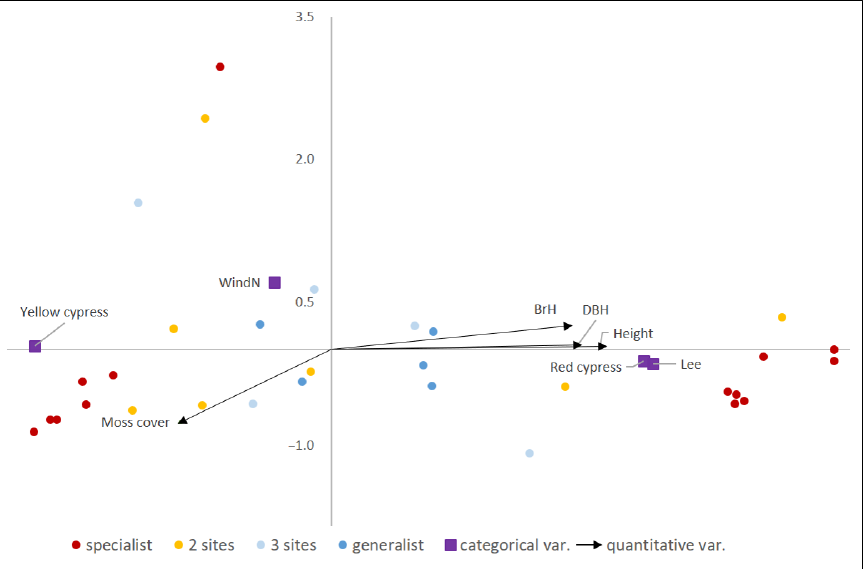
Figure 8. Triplot graph of canonical correspondence analysis (CCA) showing the scores of epiphytic species (circles), category variables (squares: site, host ‐ tree species), and quantitative variables (line arrows: moss ‐ cover, host ‐ tree height, DBH, and branch height (BrH)) from the study in the first two axes. Explanatory variables shown were found significant by 999 permutation tests ( p < 0.001). Warm to cold colors of circles indicate the gradient of species that occurred once (specialists) to those that occurred at all study sites (generalists). See text for further explanation.